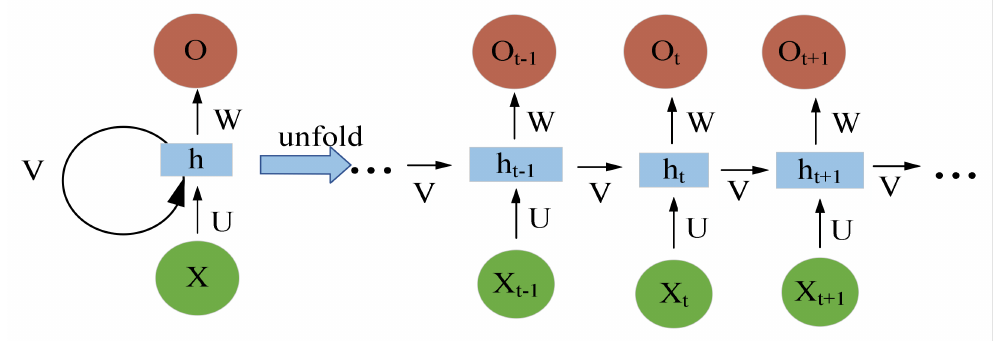
Figure 3. RNN structure.